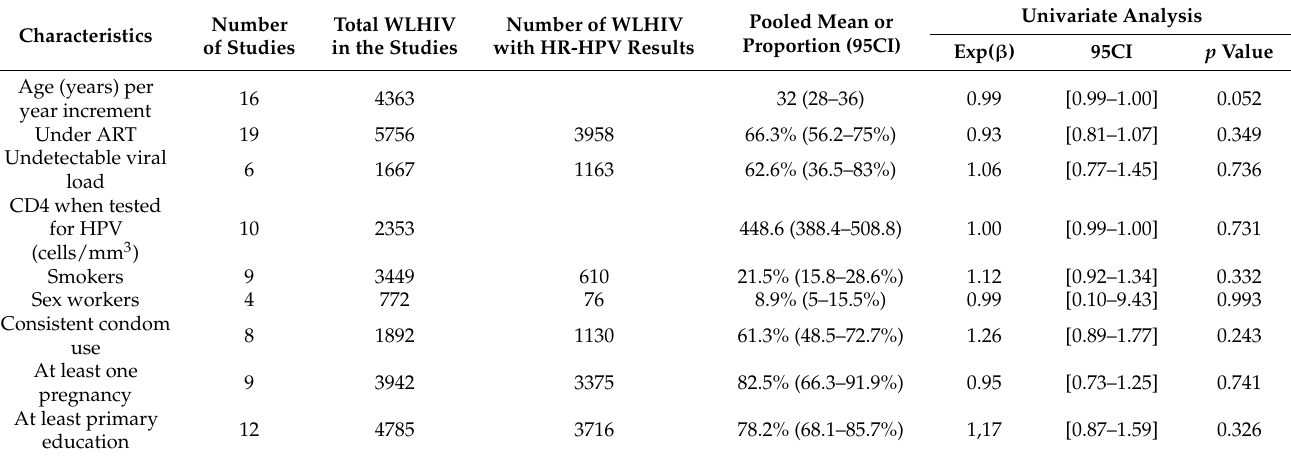
Table 2. Associations between HR-HPV prevalence and study